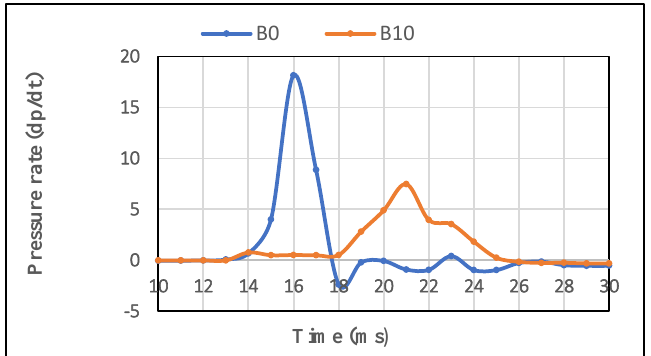
Figure 8. Rate of increase in pressure in the CVCC combustion chamber before the time of ignition.